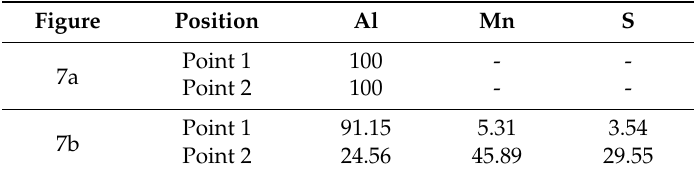
Table 4. EDS point analysis of oxides for the non-treated sample after etching shown in Figure 7 (mass